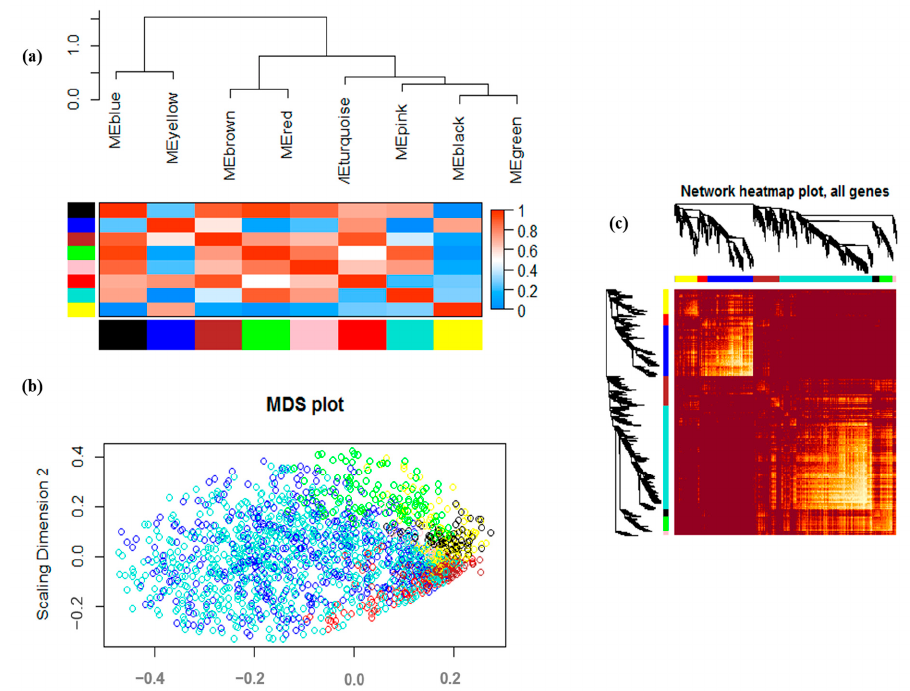
Figure 4. ( a ) The module eigengene adjacency shown by hierarchical clustering and heatmap. A module eigengene (ME) summarizes the gene expression profile of each module. In the heatmap of module–module relationships, the progressively more saturated blue and red colors indicate high co-expression interconnectedness. ( b ) Multidimensional expansion map (MDS) of each gene located in a module of the soybean drought stress dataset. MDS plot demonstrating the similarity of gene expression patterns between different modules. ( c ) In the topological overlap matrix (TOM) plot, darker red color represents low overlap, while progressively lighter color represents higher overlap among DEGs. Blocks of darker colors along the diagonal correspond to the modules. The gene dendrogram and module assignment are also shown along the left-hand side and the top.